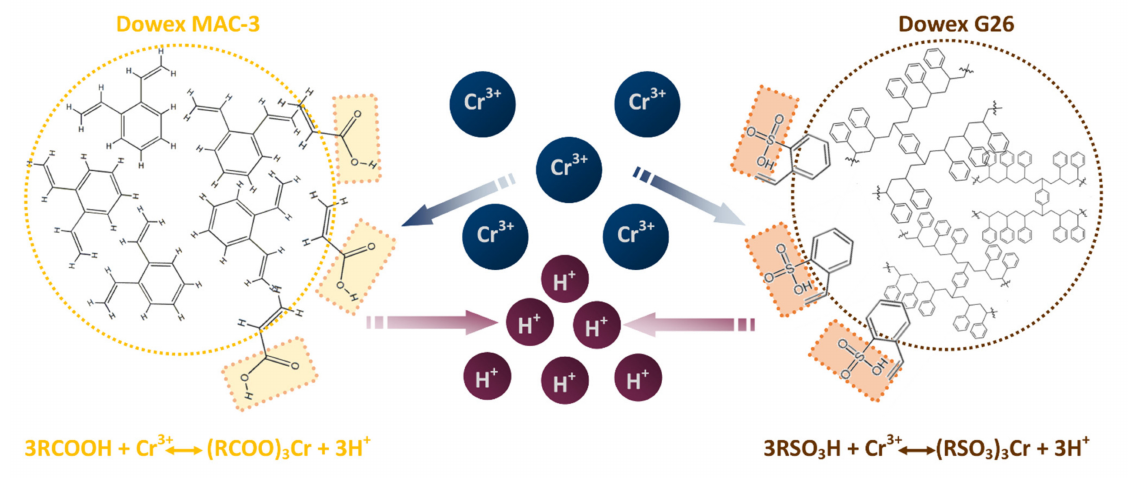
Figure 2. The graphical representation of the mechanism of Cr(III) adsorption with Dowex G26 and MAC-3.